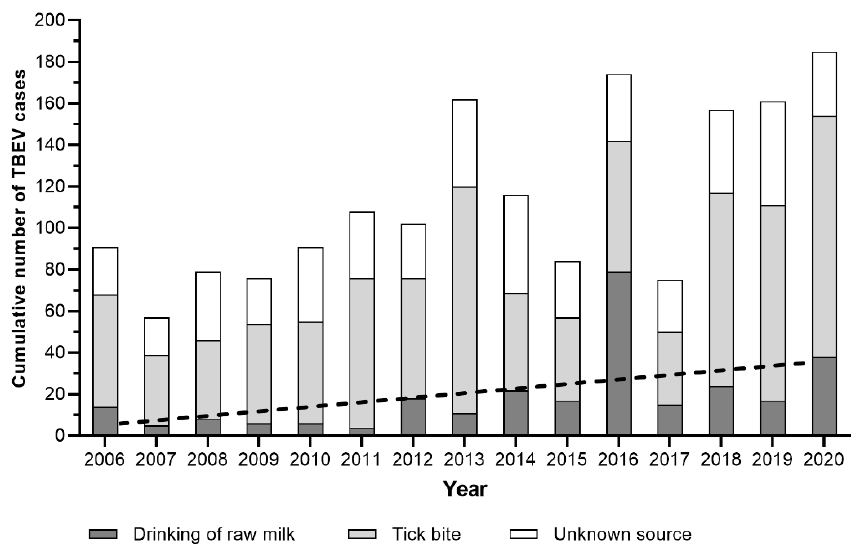
Figure 2. Epidemiology anamnesis of human cases of TBEV in Slovakia (source: www.uvzsr.sk (accessed on 23 December 2021)). The dashed line represents a linear trendline for the alimentary in- fections.